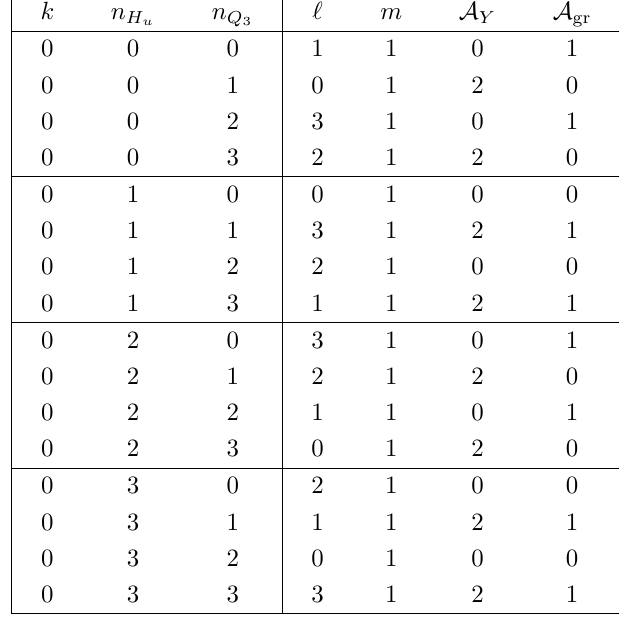
and n Q . The other charges u 3 =n Y is U(1) Y